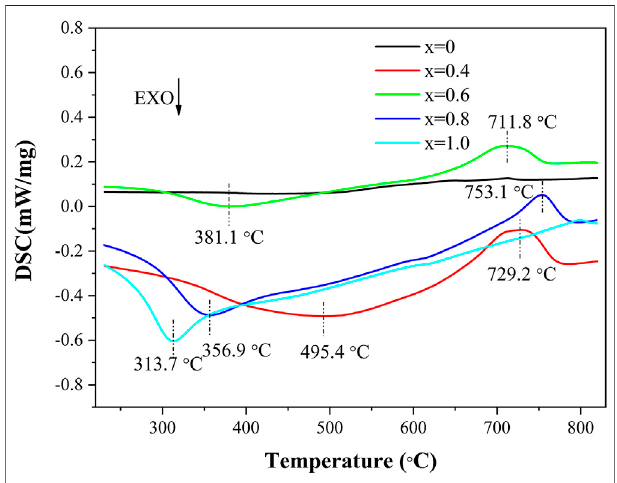
FIGURE 2 | DSC curves of 40 h-milled FeCoNi(CuAl) x MEA and HEA powders.